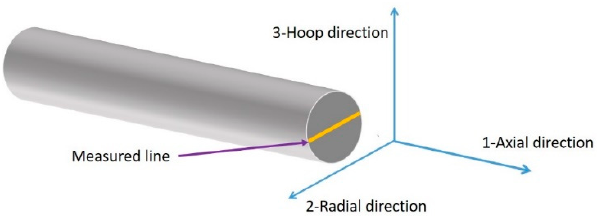
Figure 1. Sketch of the sample indicating the three orthogonal strain directions: axial (z-direction, denoted also as (1), radial (2) and hoop (3).